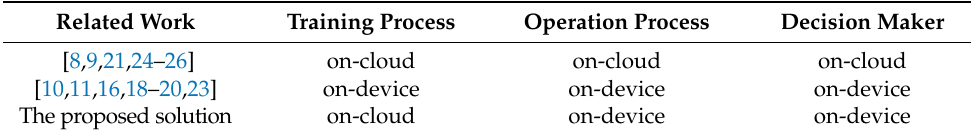
Table 1. The relevant work comparison.